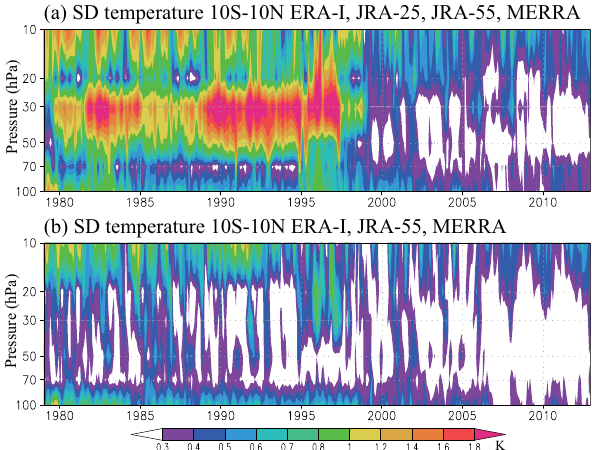
Figure 14. Time–height cross sections of zonal mean standard de- viation of temperature among (a) four reanalyses (ERA-I, JRA-25, JRA-55, and MERRA) and (b) three reanalysis (ERA-I, JRA-55, and MERRA) at 10 ◦ S–10 ◦ N from 1979 to 2012. The color inter- vals are 0.1K for values less than 0.8 and 0.2K for values more than 0.8K.